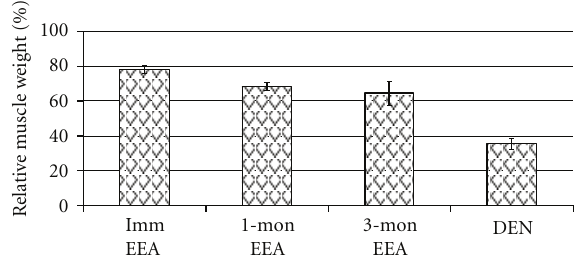
Figure 10: Average relative SM muscle weight in the denervation (DEN) and reinnervation experimental groups with immediate (Imm EEA), 1-month delay (1-mon EEA), and 3-month delay (3- mon EEA) nerve repair. SM muscle weight on the operated side was presented as a percentage of the SM muscle weight on the control